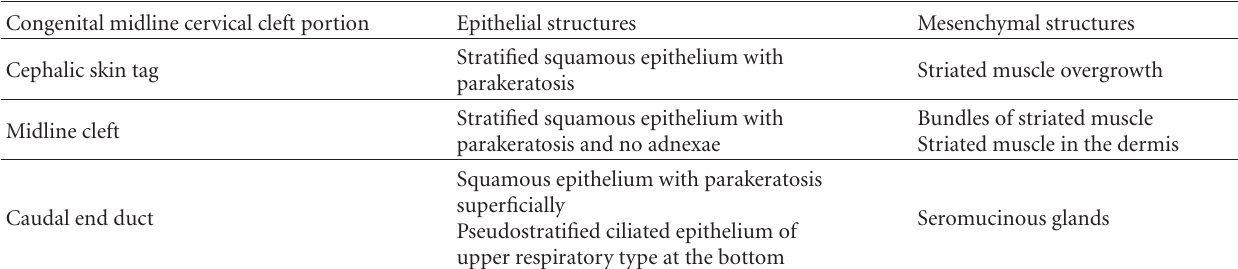
Table 1: Pathologic findings of the parts of the congenital midline cervical cleft. Congenital midline cervical cleft portion Epithelial structures Mesenchymal structures Stratified squamous epithelium with Cephalic skin tag parakeratosis Stratified squamous epithelium with parakeratosis and no adnexae